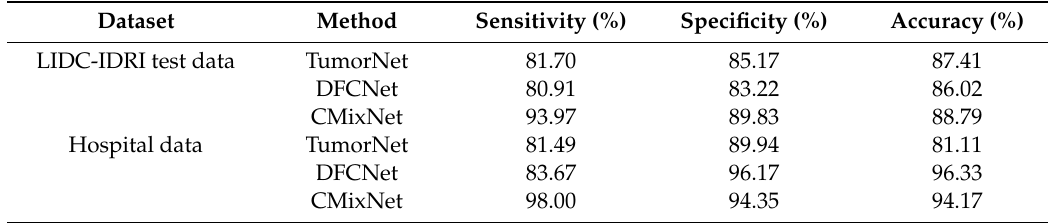
Table 6. Performance comparison of TumorNet [34], DFCNet [14], and CMixNet.